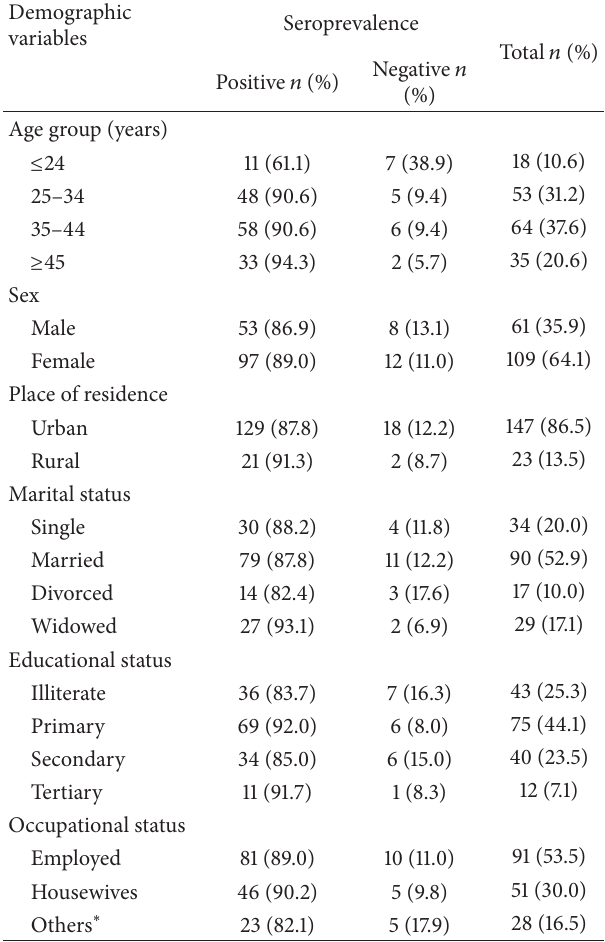
Table 1: Demographic profile and seroprevalence of latent Toxo- plasma gondii infection among the study participants ( 𝑛 = 170 ) in Arba Minch Hospital,